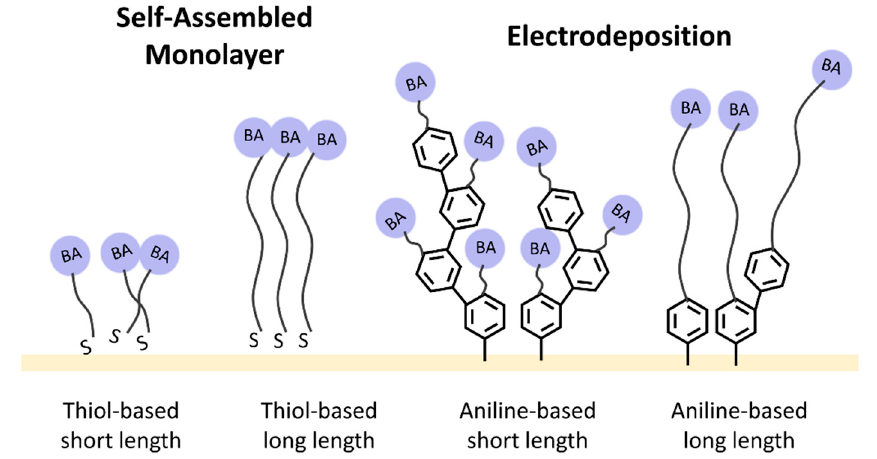
Figure 4. Derivatives of BA spacers: aniline-based BA modified through electrodeposition and thiol- based BA modified through SAM on a QCM chip.